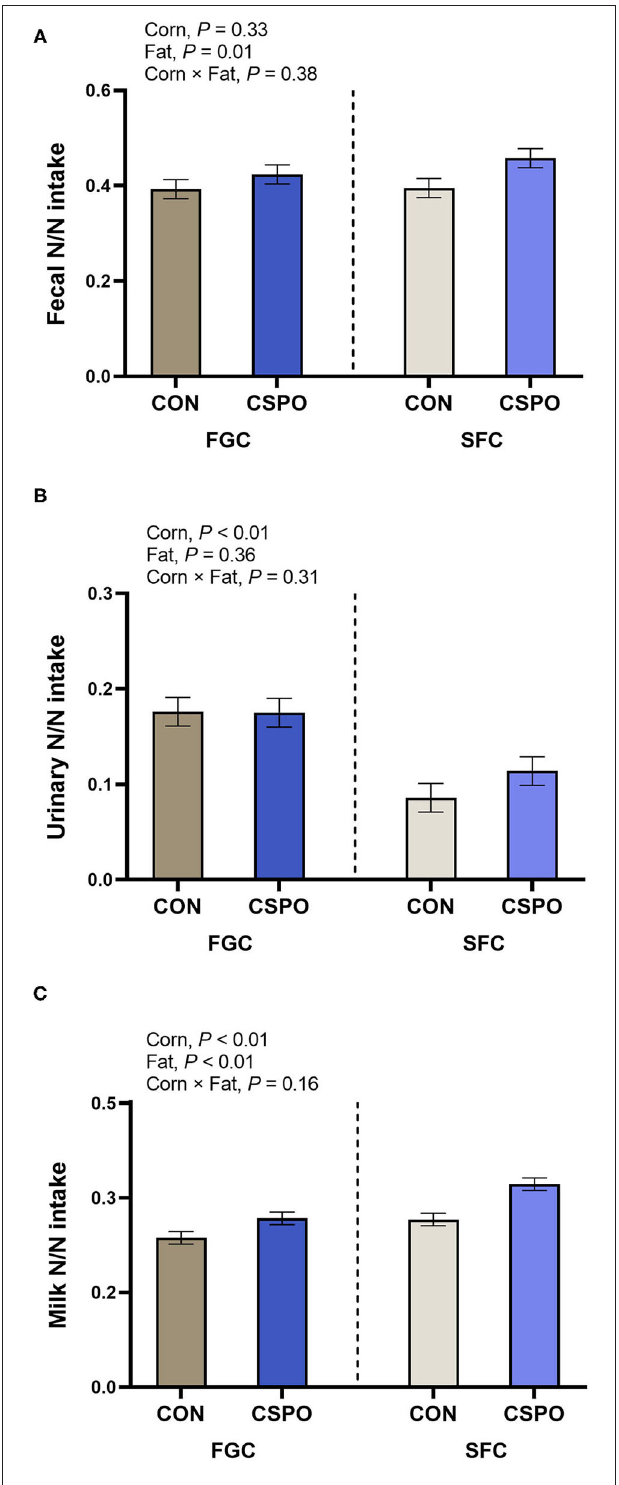
FIGURE 1 | Apparent nitrogen digestion (A) and nitrogen excretion in urine (B) and milk (C) in cows that grazed elephant grass and received treatments as a concentrate supplement. The concentrate contained either fine ground corn (FGC) or steam-flaked (SFC) corn associated or not with supply of Ca salts of palm fatty acids (not supplemented—CON or